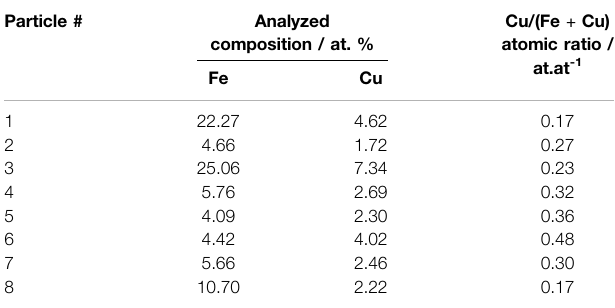
TABLE1| Quanti fi edphasecompositionsinthealloyedFe-Cunanoparticlesfrom the STEM/EDS maps for the reduced Fe-Cu(0.17)/Al 2 O 3 with total metal loading of 15 wt% a